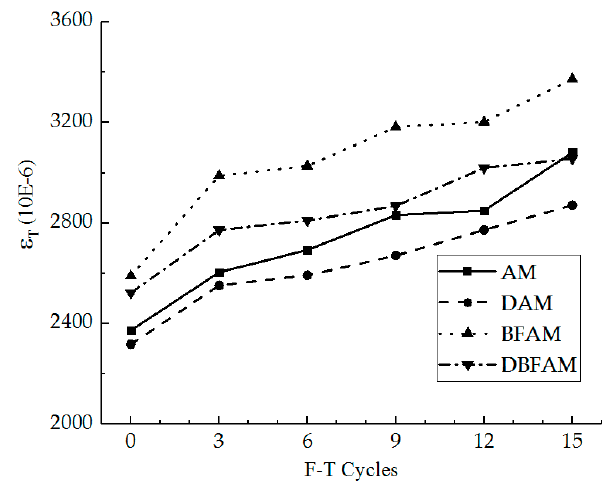
Figure 7. IDT failure strain under F–T cycles.